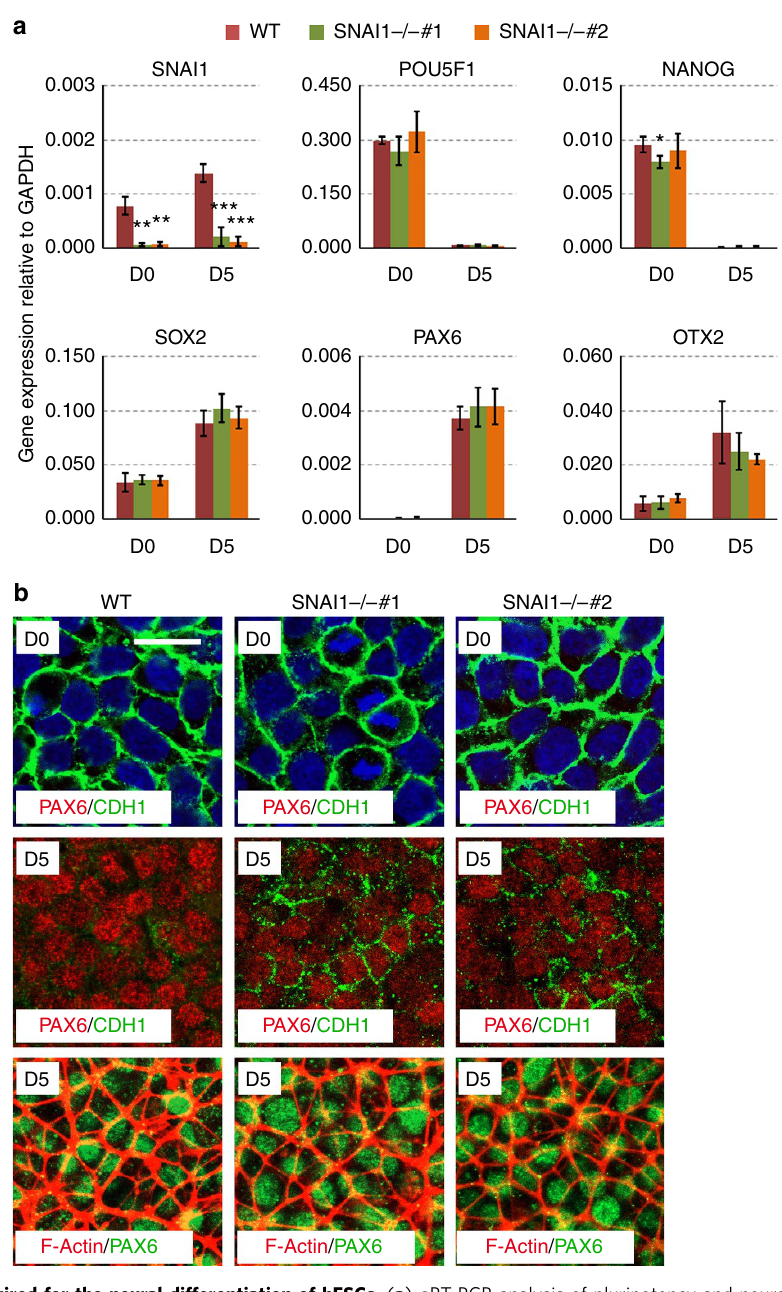
Figure 8 | SNAI1 is not required for the neural differentiation of hESCs. ( a ) qRT-PCR analysis of pluripotency and neural lineage marker in WT and SNAI1 knockout lines after 5 days of 2i treatment. Data represent mean ± s.d. from three biological repeats. Significance between WT and mutants were determined by Student’s unpaired t -test (* P o 0.05, ** P o 0.01; *** P o 0.001). ( b ) Immunofluorescence staining of WTand SNAI1 knockout hESCs after 2i treatment. Scale bar, 20 m